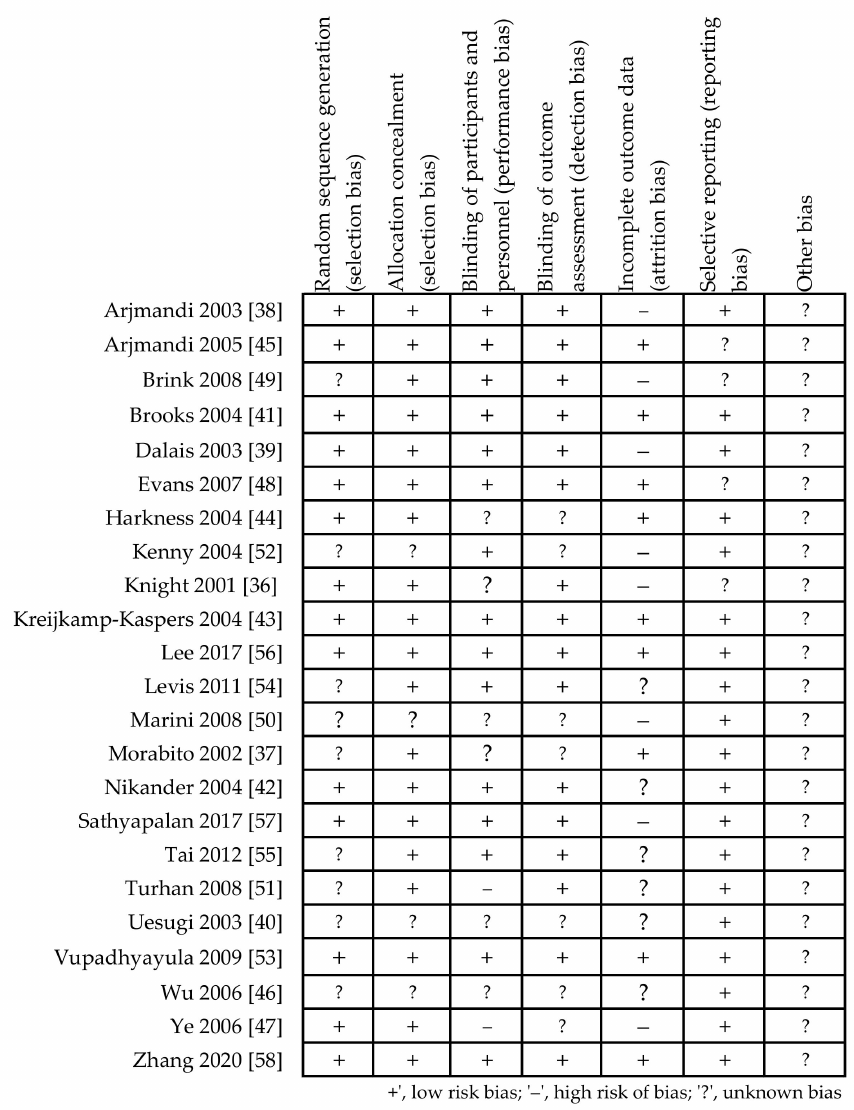
Figure 2. Summary of Cochrane risk of bias of methodological quality for each covered